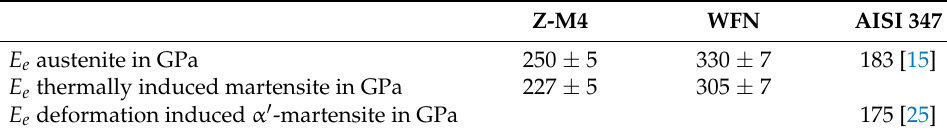
Table 7. Elastic moduli for austenitic and martensitic